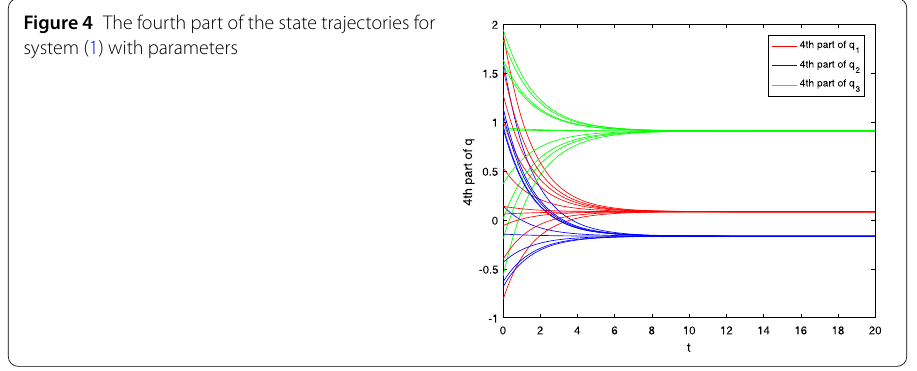
Figure 4 The fourth part of the state trajectories for system (1) with